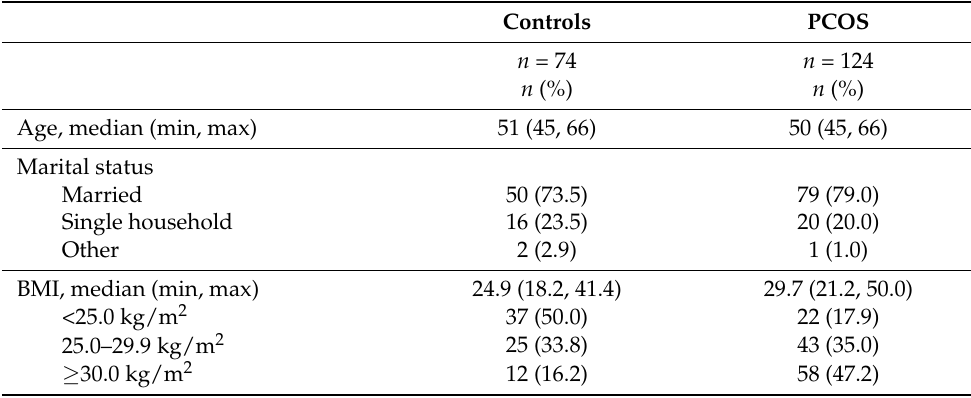
Table 1. Demographic information of study